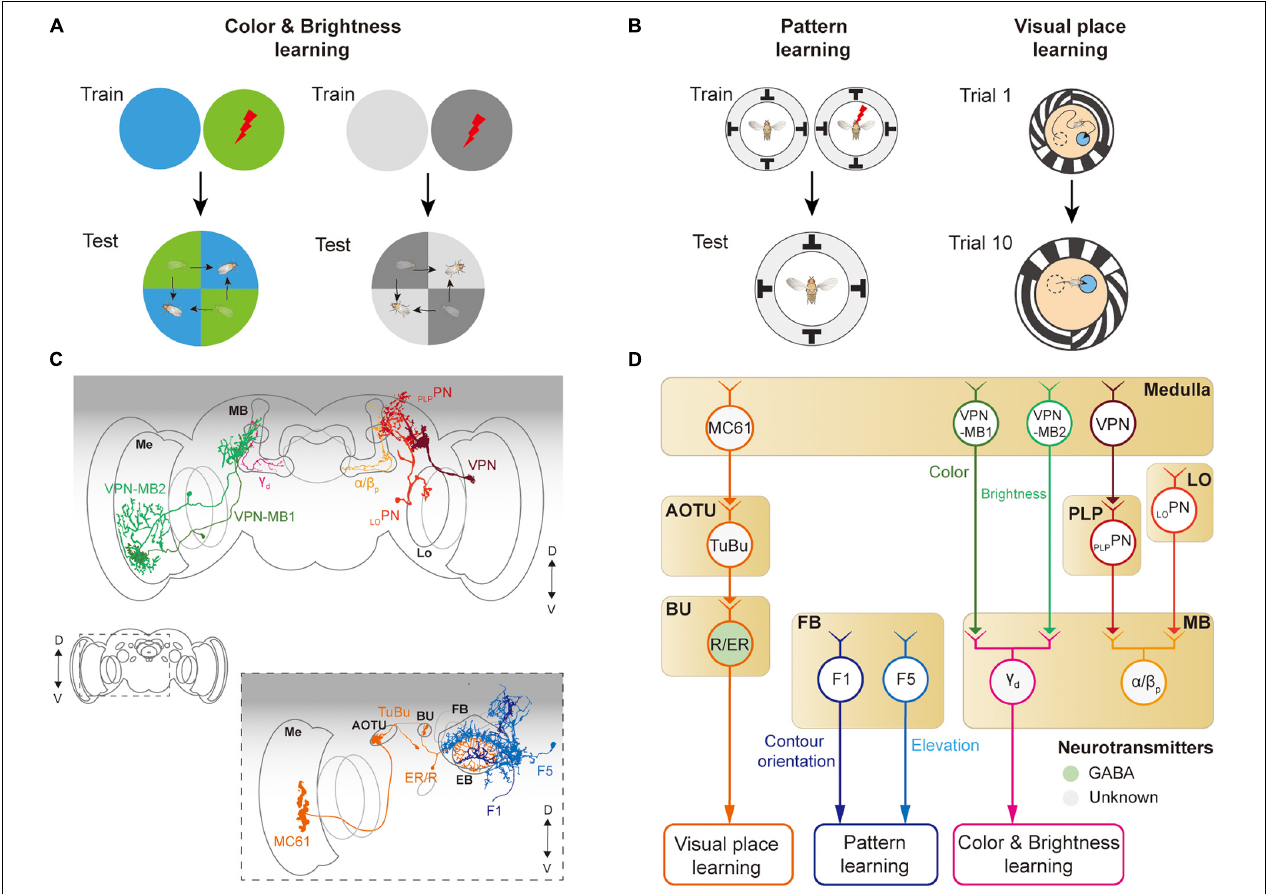
FIGURE 7 | Neural circuits underlying visually learning. (A) When specific color or brightness were conditioned by a punitive stimulus, flies tend to avoid the conditioned visual feature. (B) When a flying or walking fly experiences heat shock for a specific visual pattern or landscape, flies learn to avoid the direction toward the pattern or remember the location of a cool spot. Each image of the behavioral setup depicts a top view of a cylindrical display arena. (C) Schematic illustration of neurons related to the visual learning. Graphical depiction is adapted from Vogt et al. (2016) and Li et al. (2020). The colors of neurons match those in panel (D) . Me: medulla, Lo: lobula, OG: optic glomeruli, AOTU: anterior optic tubercle, BU: bulb, PB: protocerebral bridge, EB: ellipsoid body, FB: fan-shaped body, MB: mushroom body. (D) Schematic diagram of neural circuits related to visual learning. The face color of a circle represents the type of neurotransmitters, and the line colors match those in panel (C) . OG: optic glomeruli, PLP: posterior lateral